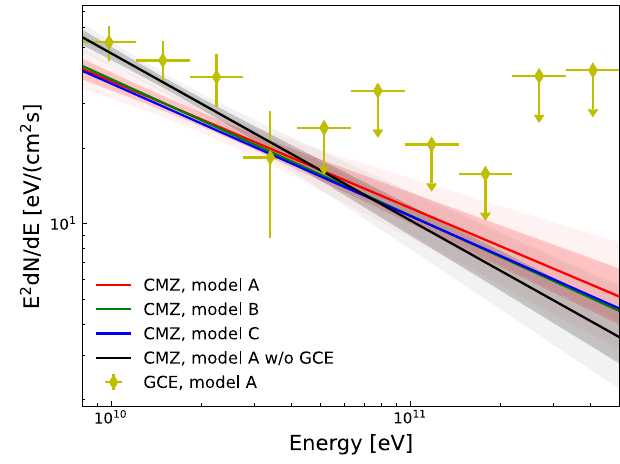
Fig. 3 Δ χ 2 as a function of the power-law index of the CR density pro fi le, α . The smaller the Δ χ 2 , the better the fi tting. Results, corresponding to the GDE models A, B, and C from ref. 33 , with different assumptions on the source distributions, the diffusion coef fi cients, and the re-acceleration parameters of CRs (see Table 2 of ref. 33 for more details about different GDE models A, B, and C), for the off-CMZ region, are shown in red, blue, and green solid lines, respectively. The black solid line is for the fi tting using the GDE model A without the inclusion of the GCE. Source data are provided as a Source Data fi le.